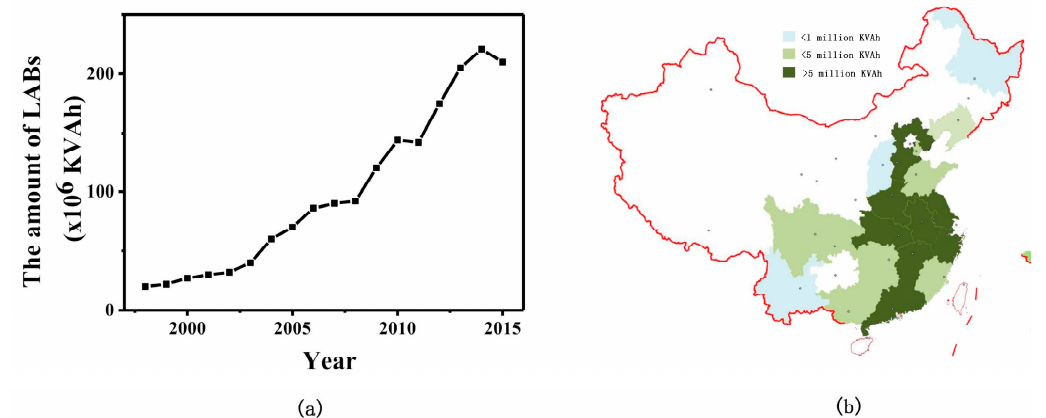
Figure 4. ( a )The amount of the production of LABs from 1998 to 2015 in China; and ( b ) The production layout of LABs in China in 2015.